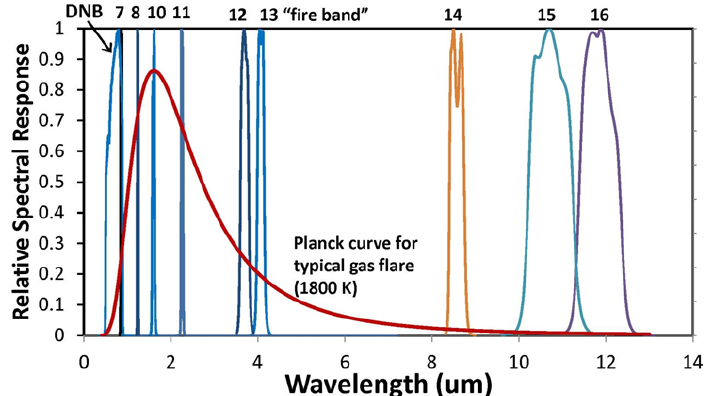
Figure 2. Relative spectral response of visible infrared imaging radiometer suite (VIIRS) bands and the Planck curve of typical gas flares at 1800 K. Day night band: DNB.